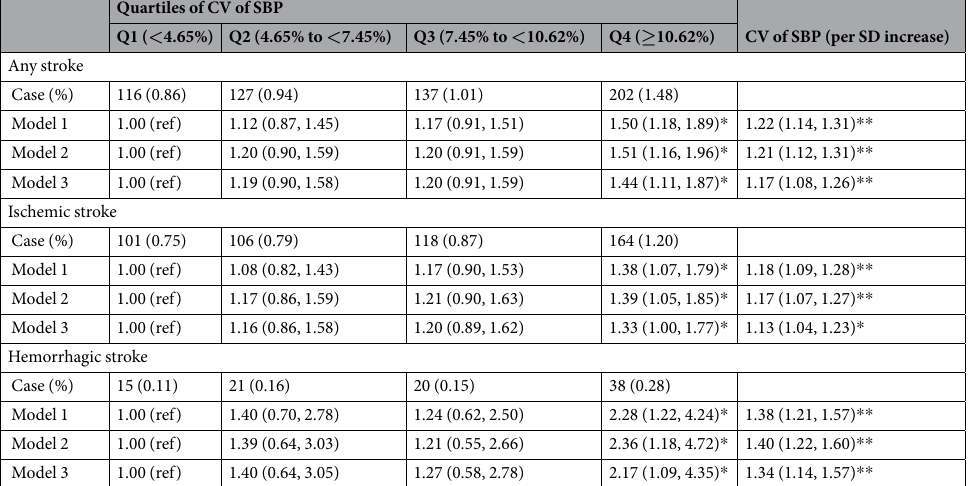
Table 2. Hazard ratios for stroke by quartiles of coefficient of variation of systolic blood pressure and per SD increases in the coefficient of variation. Case (%): number of events (cumulative incidence%). Model 1: adjusted for age, gender, and body mass index. Model 2: further adjusted for current smoking, current drinking, education level, income level, physical activity, heart rate, diabetes mellitus, dyslipidemia, serum uric acid, high-sensitivity C-reactive protein after logarithmic transformation, history of MI, family history of stroke, and the use of antihypertensive drugs. Model 3: further adjusted for mean of systolic blood pressure and mean of diastolic blood pressure. Per SD increase in the CV of SBP = 4.7%. * P < 0.05, ** P <